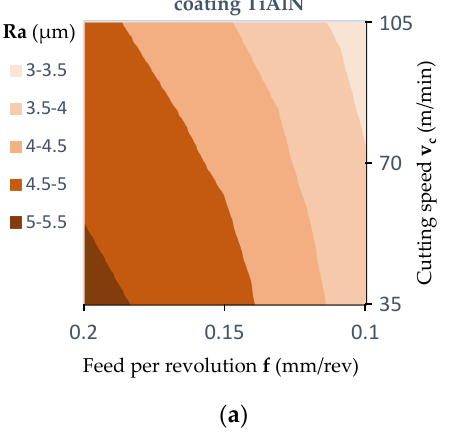
measurement area. measurement area. 378